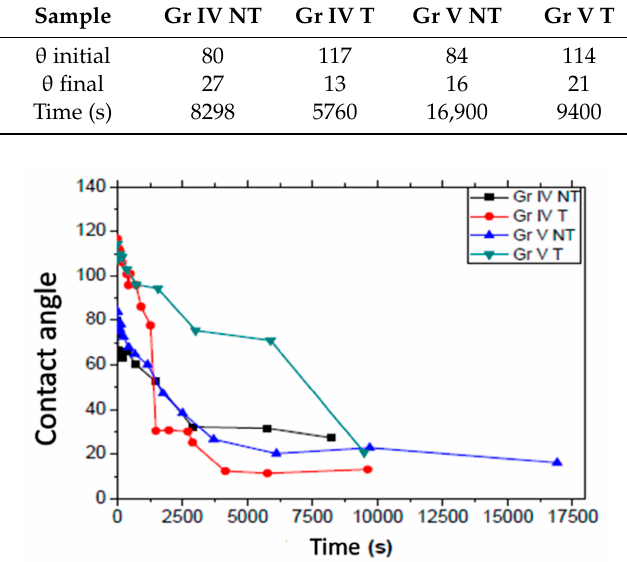
Figure 11. Image of the grade IV NT with a drop of water before ( a ) and after exposure to UV irradiation ( b ).